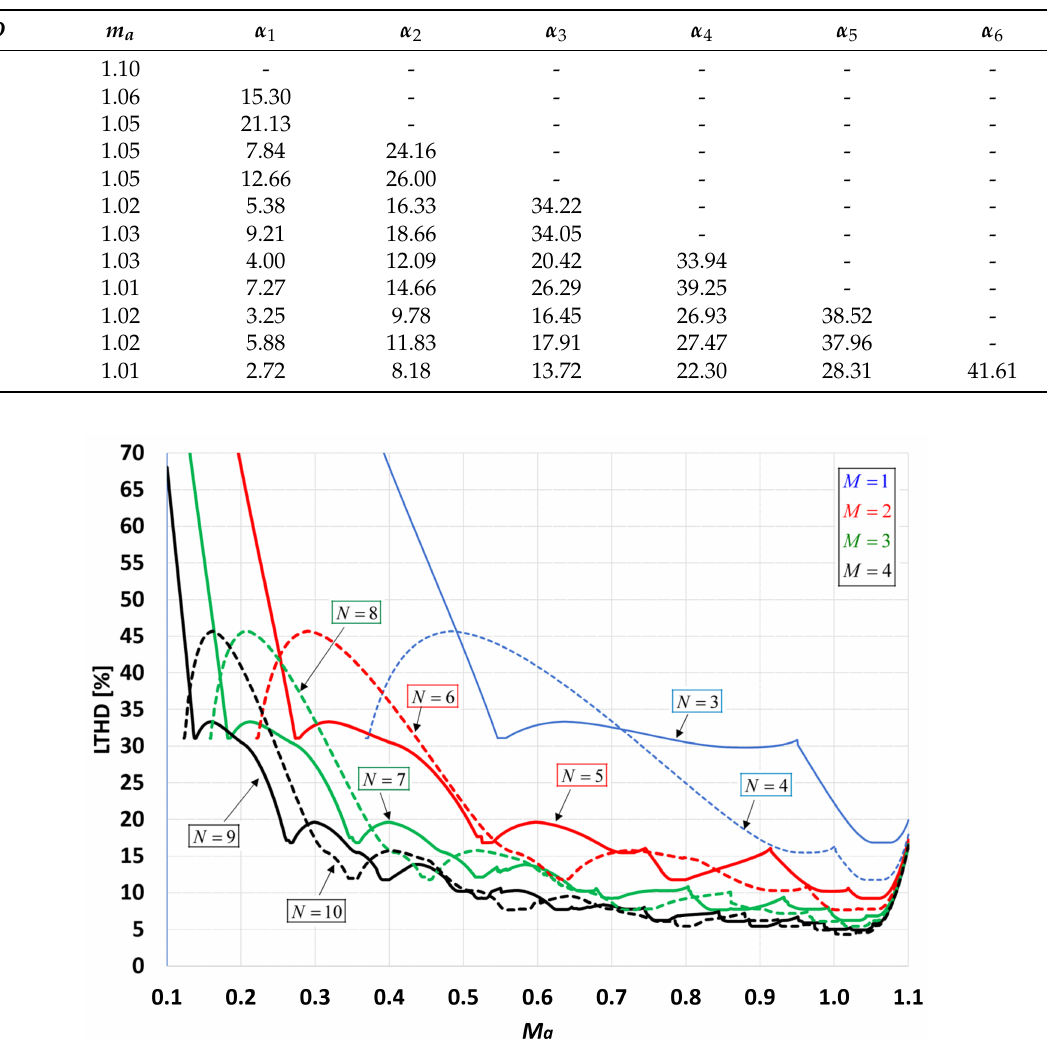
Table 2. Minimum LTHD Results, %.